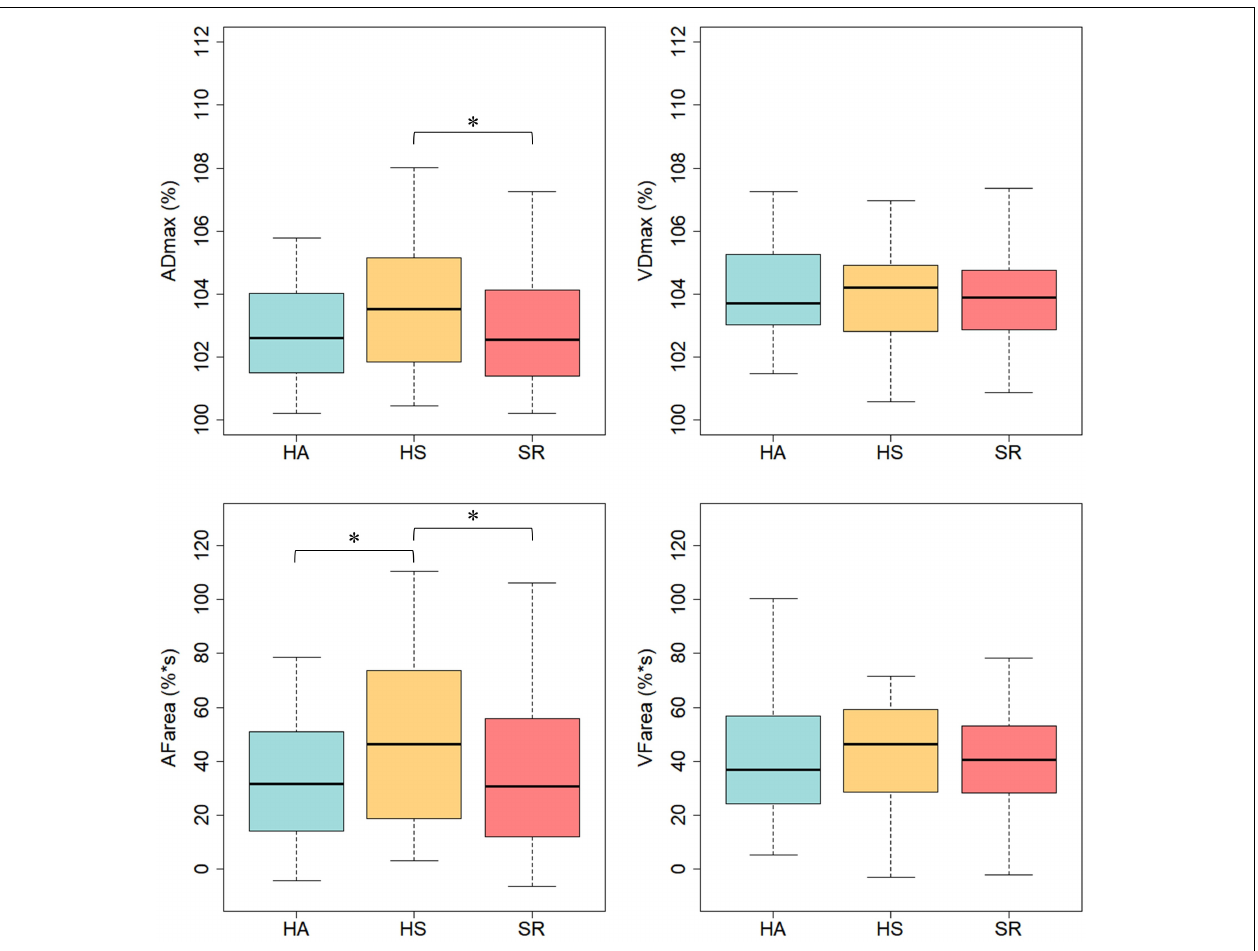
FIGURE 2 | Arteriolar and venular flicker response in healthy active (HA), healthy sedentary (HS) and sedentary individuals with increased CV risk (SR). ADmax, maximal arteriolar dilatation; VDmax, maximal venular dilatation; AFarea, integral under arteriolar flicker curve; VFarea, integral under venular flicker curve; ∗ p < 0.05 for Mann–Whitney- U